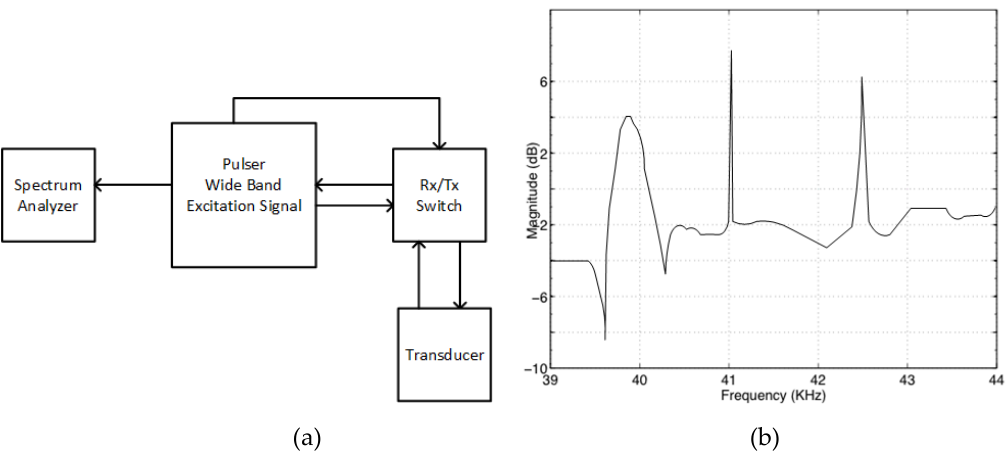
Figure 2. Characterization and measurement of transducer: ( a ) Transducer characterization setup; ( b ) The measured frequency characteristics of a 40 kHz transducer.